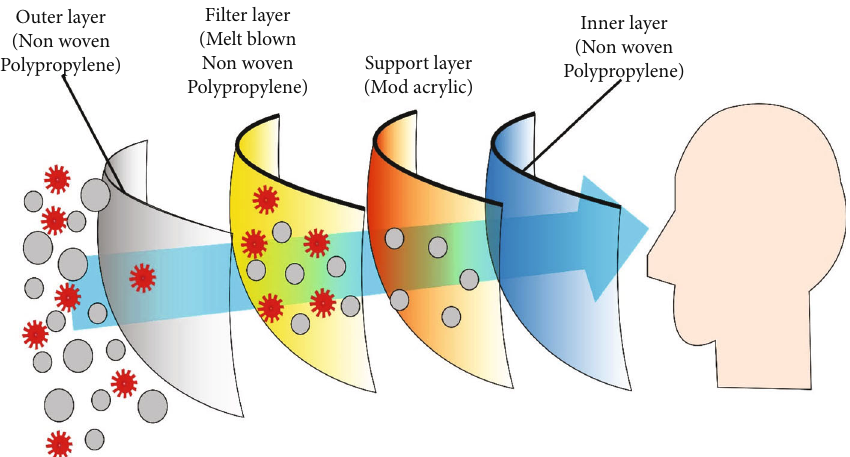
Figure 4: Multilayer N95 face